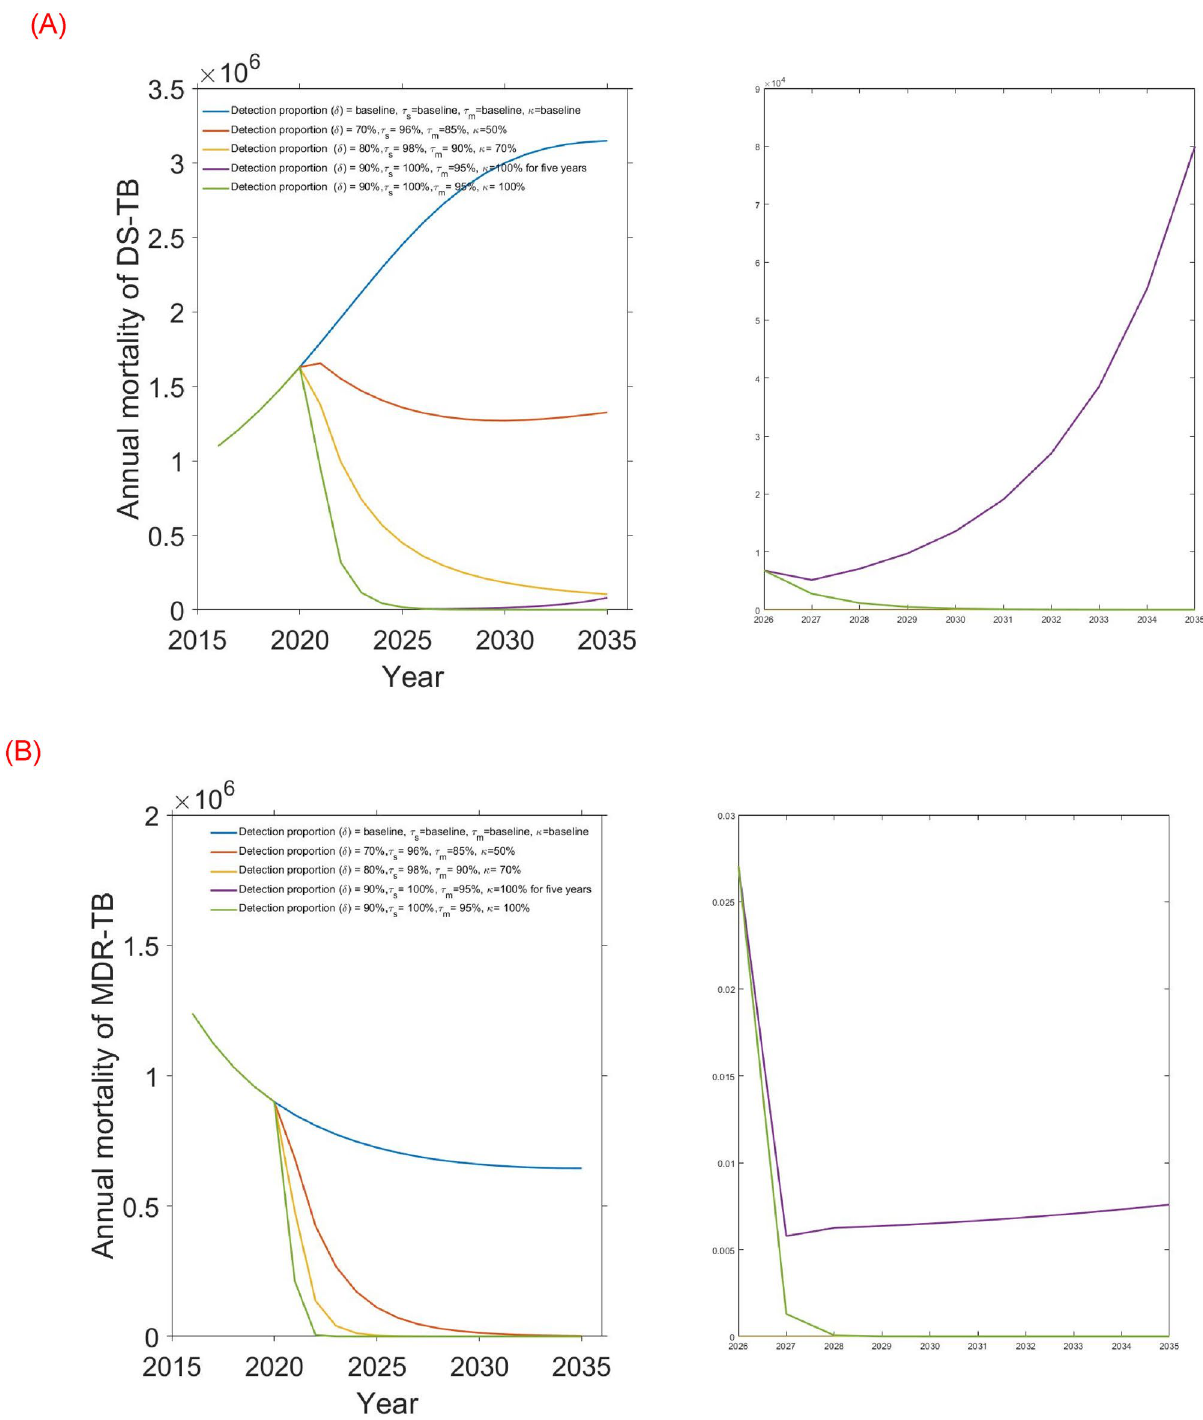
Figure 8. Combination intervention strategy and its effect on ( A ) DS-TB and ( B ) MDR-TB annual mortality in